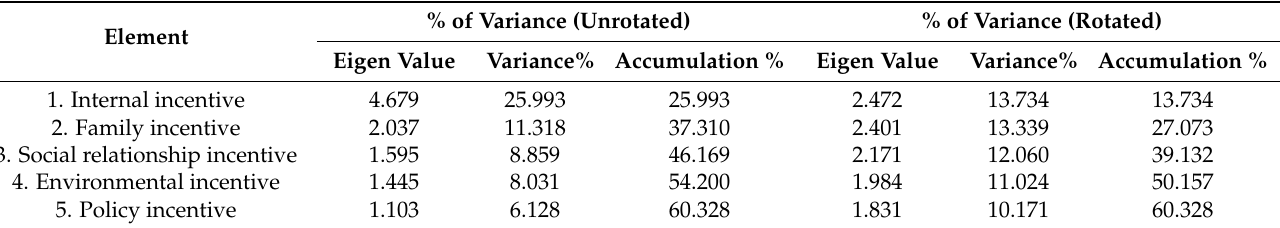
Table 5. Explanation of total variance.